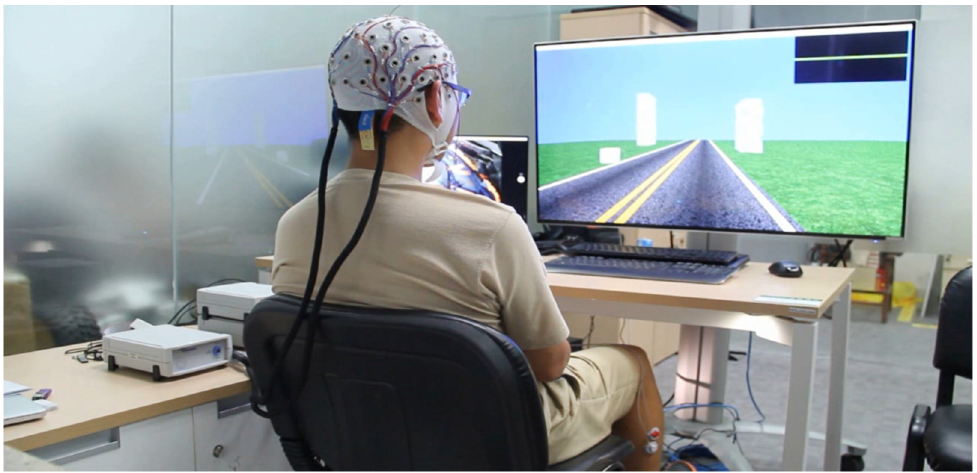
Figure 2. A VR-MRCP-based BCI neurorehabilitation device [47].